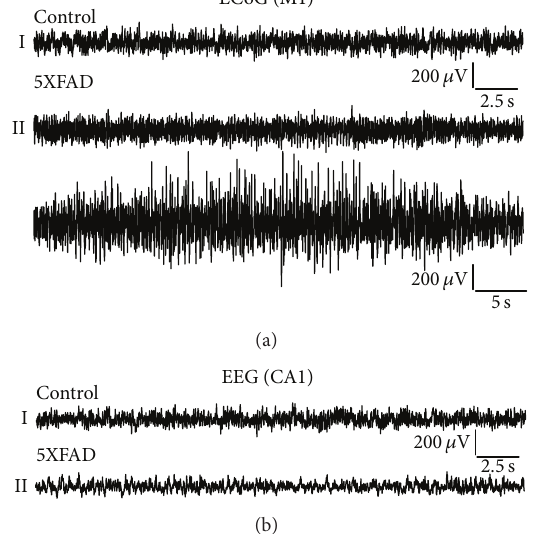
Figure1:Electroencephalographic(EEG)characteristicsofcontrols and 5XFAD mice. EEGs recorded from the primary motor cortex (M1) as electrocorticogram (ECoG) (a) and the hippocampal CA1 region as electrohippocampogram (b) from both WT and 5XFAD mice. In the CA1 electrohippocampogram neither controls (b)I nor 5XFAD mice (b)II exhibited typical ictal discharges in 48 h long- term recordings. Electrocorticographic M1 recordings, however, exhibited subclinical, that is, electroencephalographic seizure activ- ity in 5XFAD mice of different severity (a)II that was not detectable in control mice (a)I. (a)I, (b)I, and b(II): 30 sec duration; (a)II 50sec